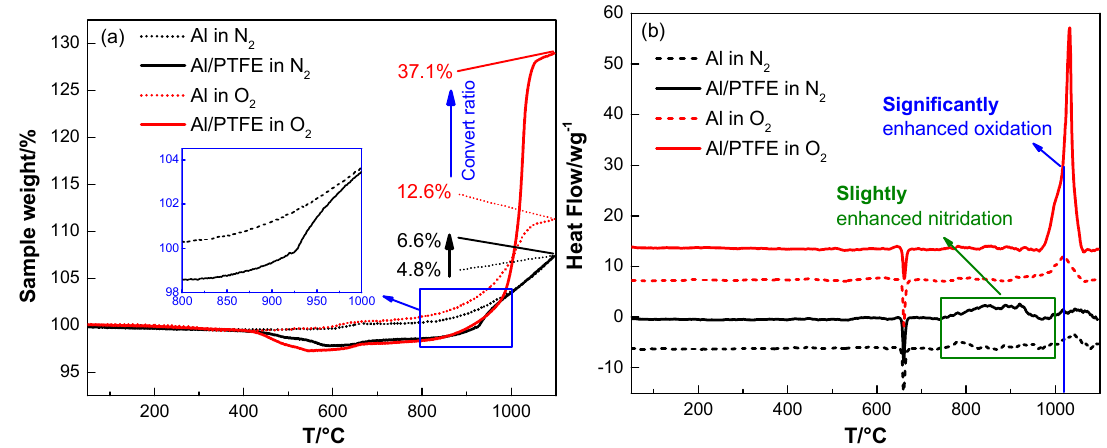
Figure 8. TGA / DSC curves of Al and Al / PTFE in N 2 and O 2 atmosphere, ( a ) TGA; ( b ) DSC. The heating Figure 8. TGA/DSC curves of Al and Al/PTFE in N 2 and O 2 atmosphere, ( a ) TGA; ( b ) DSC. The heating rate is 10 K / rate is 10 K/min.